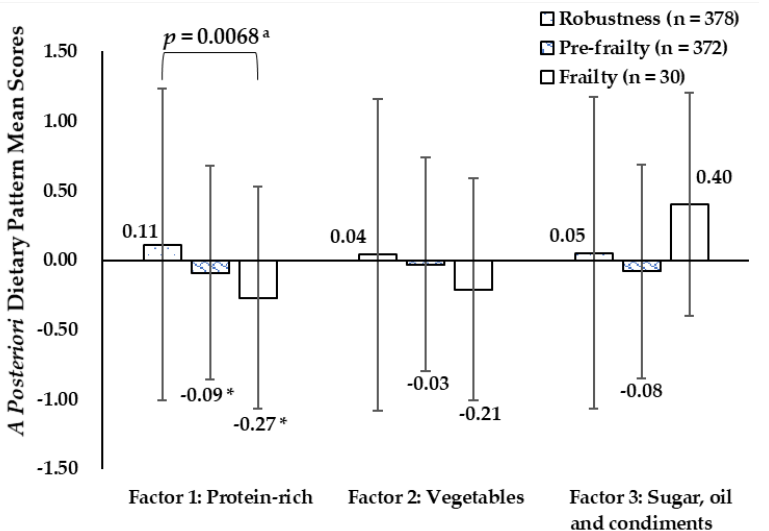
Figure 2. A posteriori dietary pattern mean sores of participants by frail status. a p -value between robust, pre-frail, and frail participants by one-way ANOVA , Bonferroni post hoc test. * p < 0.05, compared with the means in Robust groups. Table 3. Dietary pattern scores of participants by sex and age groups ( n =